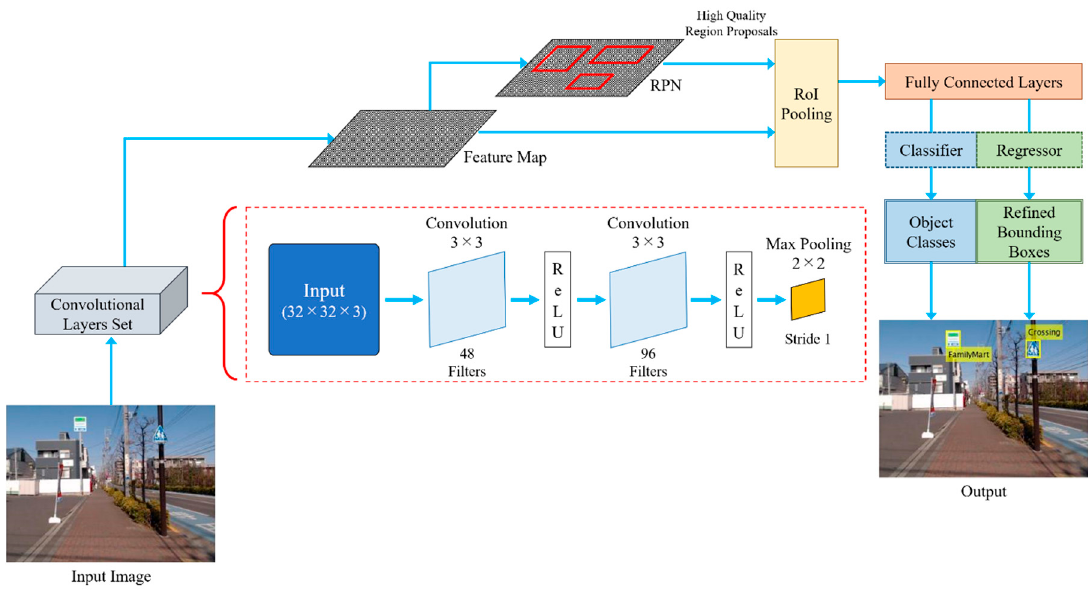
Figure 2. Faster R-CNN for landmark detection and its components.